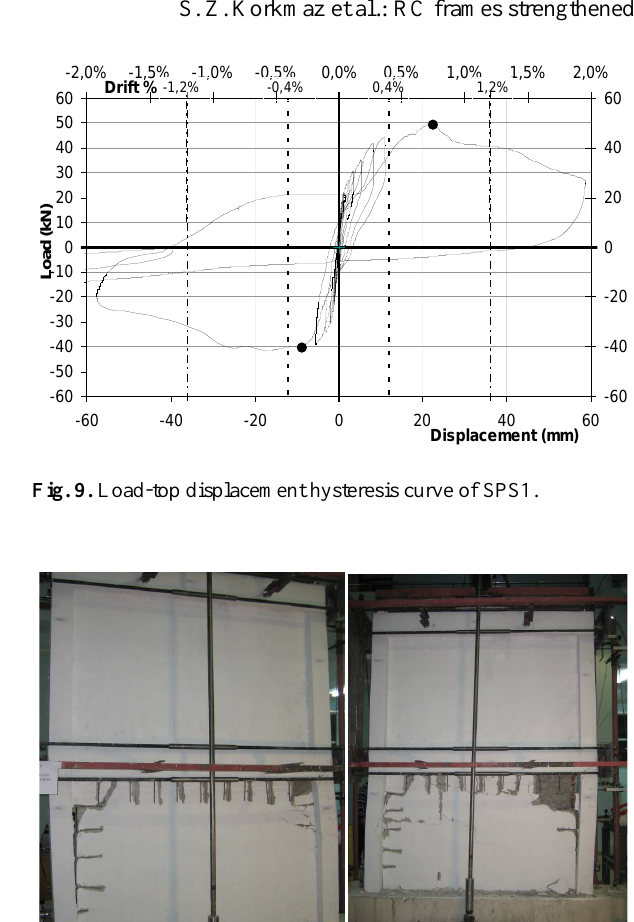
Figure 10 Failure mode of specimen SPS1 Fig. 10. Failure mode of specimen